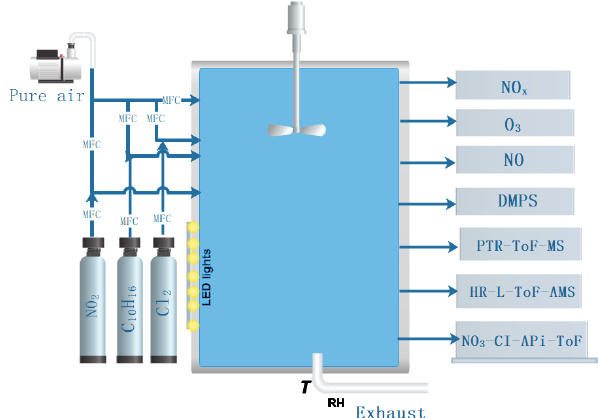
Figure 1. A schematic of the chamber set-up and instruments used in the